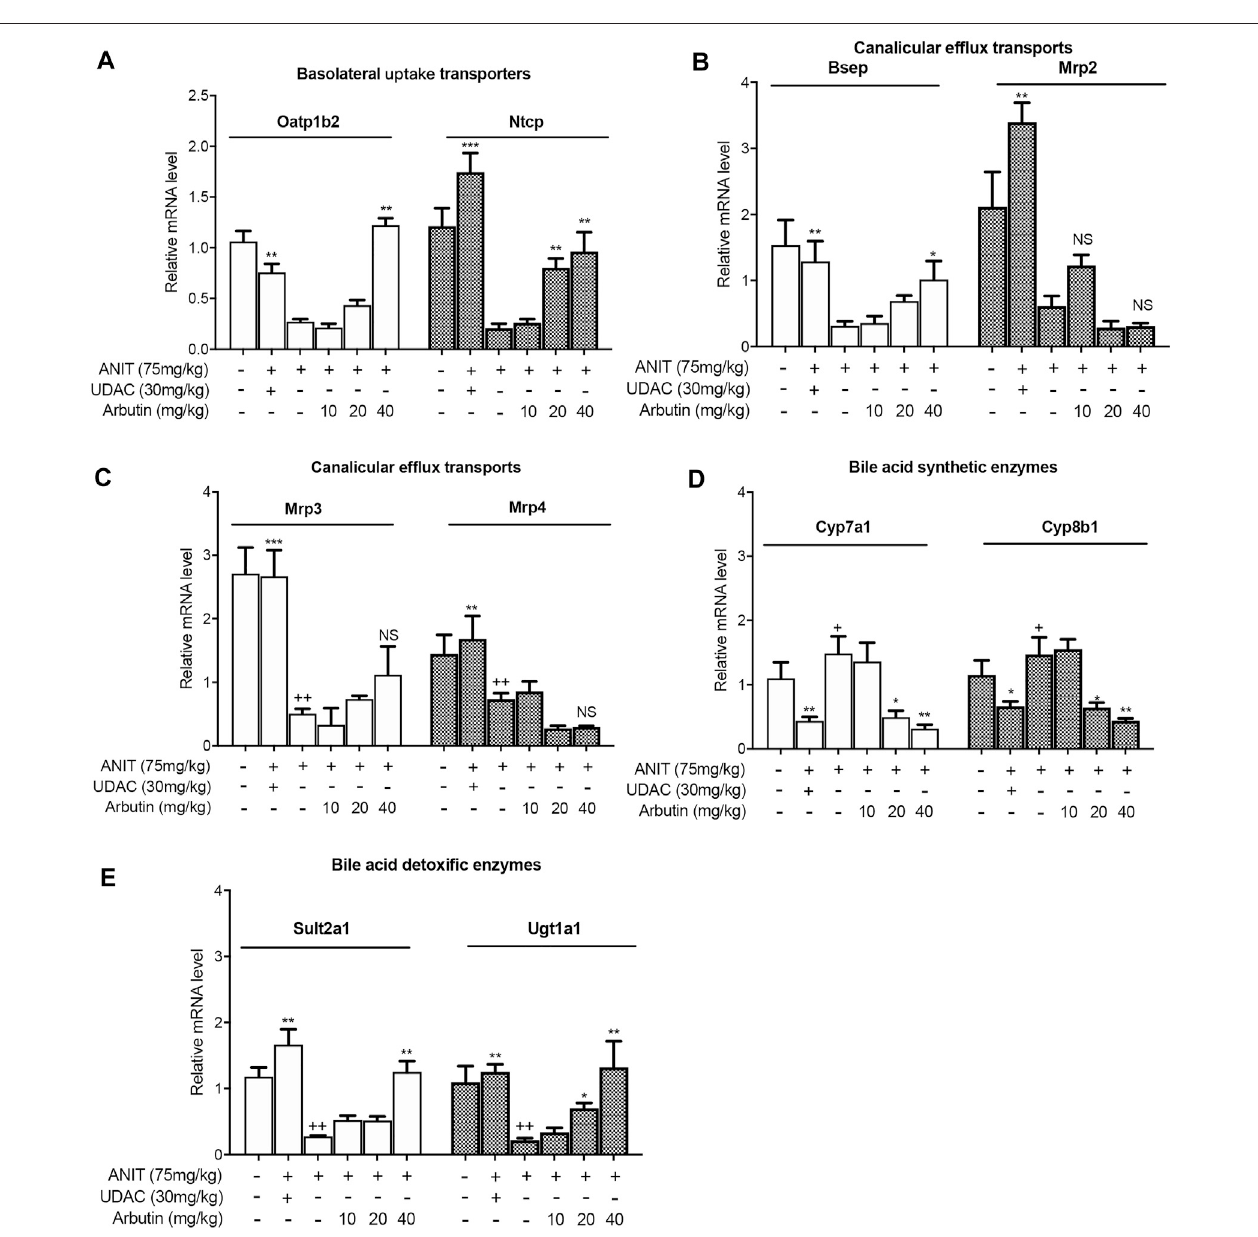
FIGURE 4 | Arbutin changed hepatic genes related to BA metabolism in mouse. Real-time PCR was performed to analyze the levels of genes related to BA metabolismincludingOatp1b2,Ntcp,Bsep,Mrp2,Mrp3,Mrp4,Cyp7a1,Cyp8b1,Sult2a1,andUgt1a1 (A – E) .Dataareexpressedasmean ± SD( n (cid:2) 3). p < 0.05;+ p < 0.05 vs. control; * p < 0.05 vs.